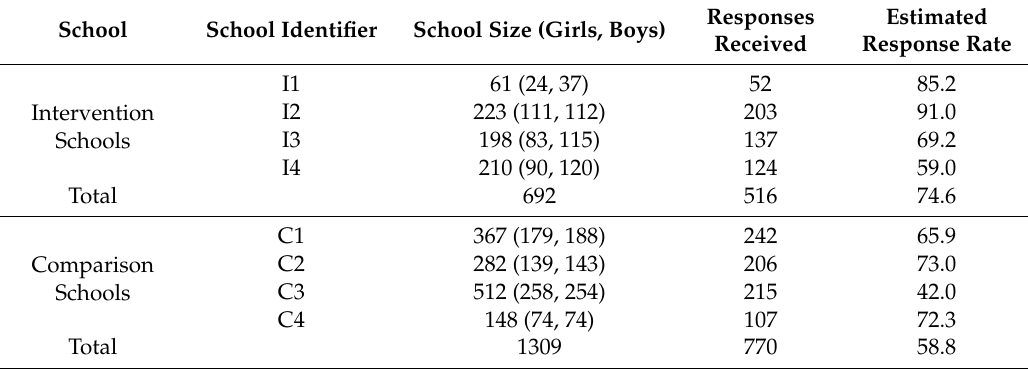
Table 2. Response rates for survey of students in intervention and comparison schools.